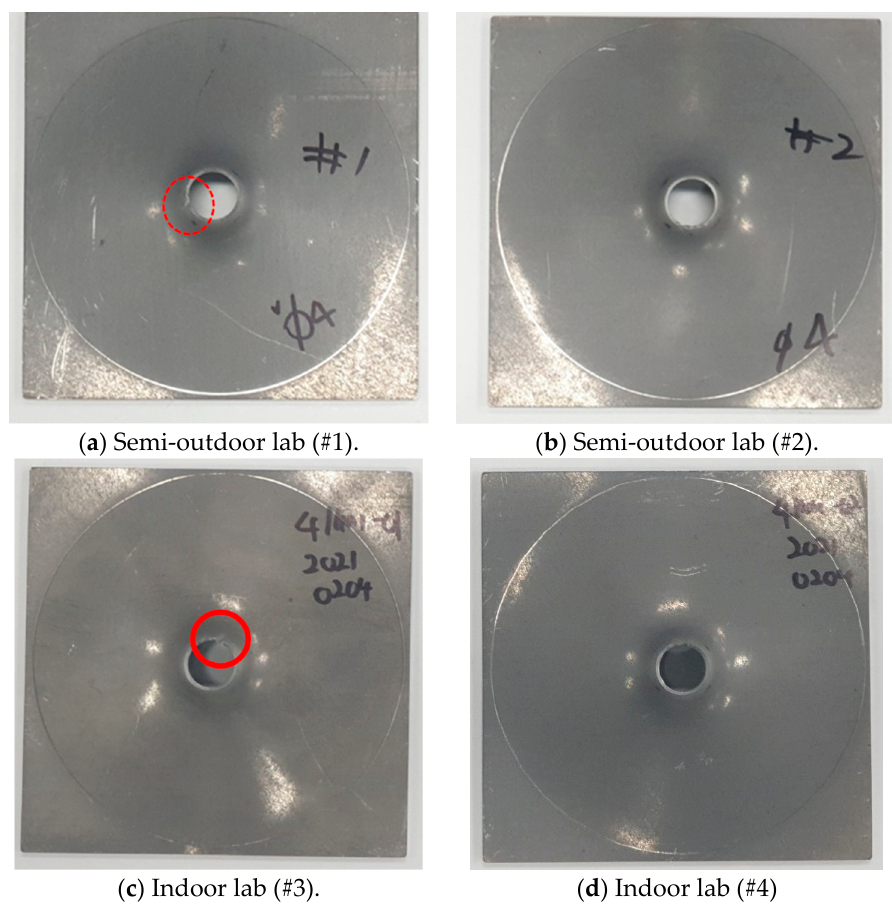
Figure 7. Images of test specimens after the hole expansion test.